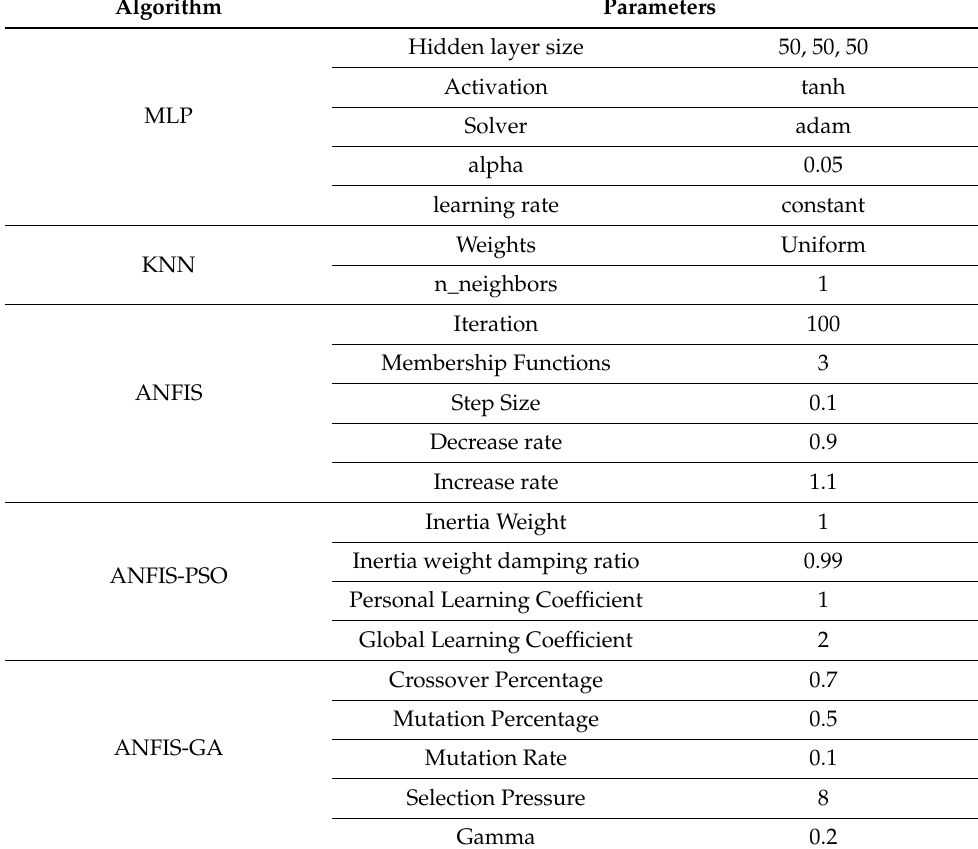
Table 2. Parameter settings for each